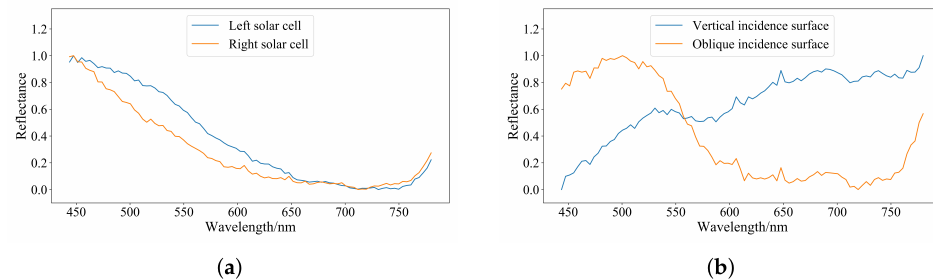
Figure 21. Spectral data distributions of high spatial resolution and negative X-axis incidence: ( a ) left and right solar cells; ( b ) gold mylar on different surfaces.